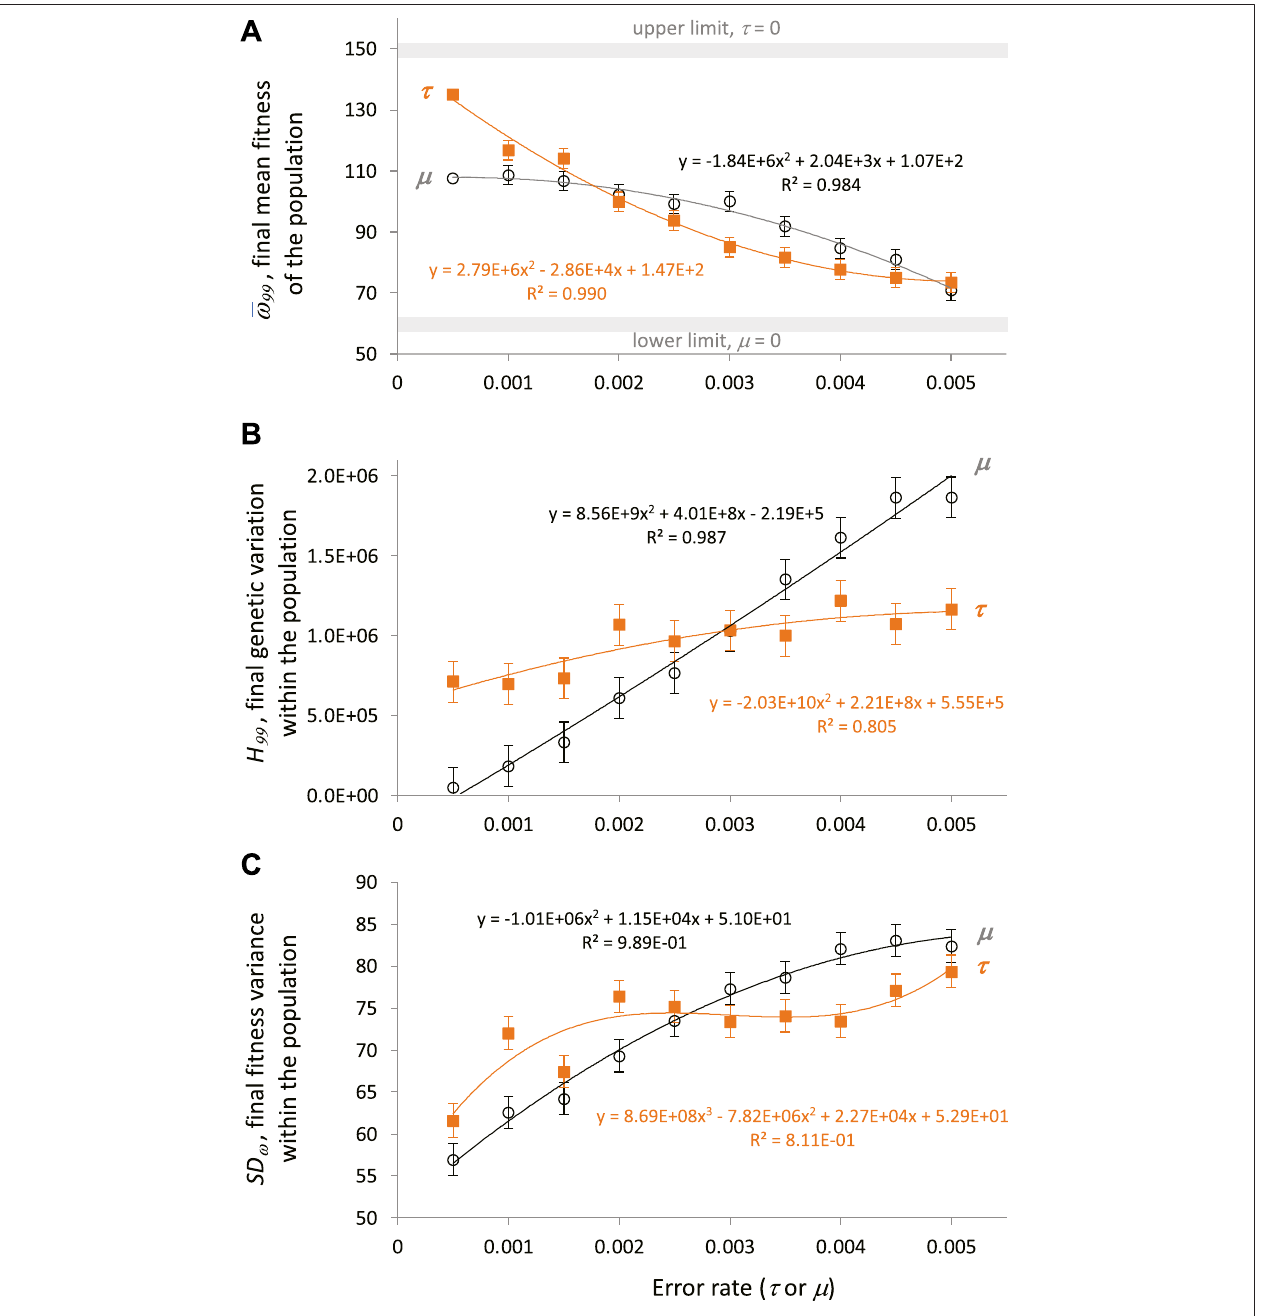
FIGURE8| Transcriptionerrorandmutationincrease geneticvariationinthefaceofdirectionalselection.Analysisofgeneration99,the fi nalgeneration,shows the cumulative impact of continuous directional selection. Points are estimated marginal means ± SE of ten populations generated by the fully factorial 10 × 10 ANOVAs. Polynomial regressions are shown for descriptive purposes only. (A) Final mean fi tness of the population decreases signi fi cantly (main effects, p < 0.05) with increasing levels of mutation and transcription error. The interaction of the main effects was not signi fi cant. (B) Final genetic variation within populations increases signi fi cantly (main effects, p < 0.05) with increasing levels of genetic mutation and transcription error. The interaction of the main effects was not signi fi cant. (C) Final fi tness variance within a population, as measured by the SD of fi tness. Final fi tness variation increases signi fi cantly (10 × 10 ANCOVA, mean fi tness as a covariate) with signi fi cantly increasing levels of genetic mutation and transcription error. The covariate and the interaction of the main effects were signi fi cant as well ( p < 0.05).